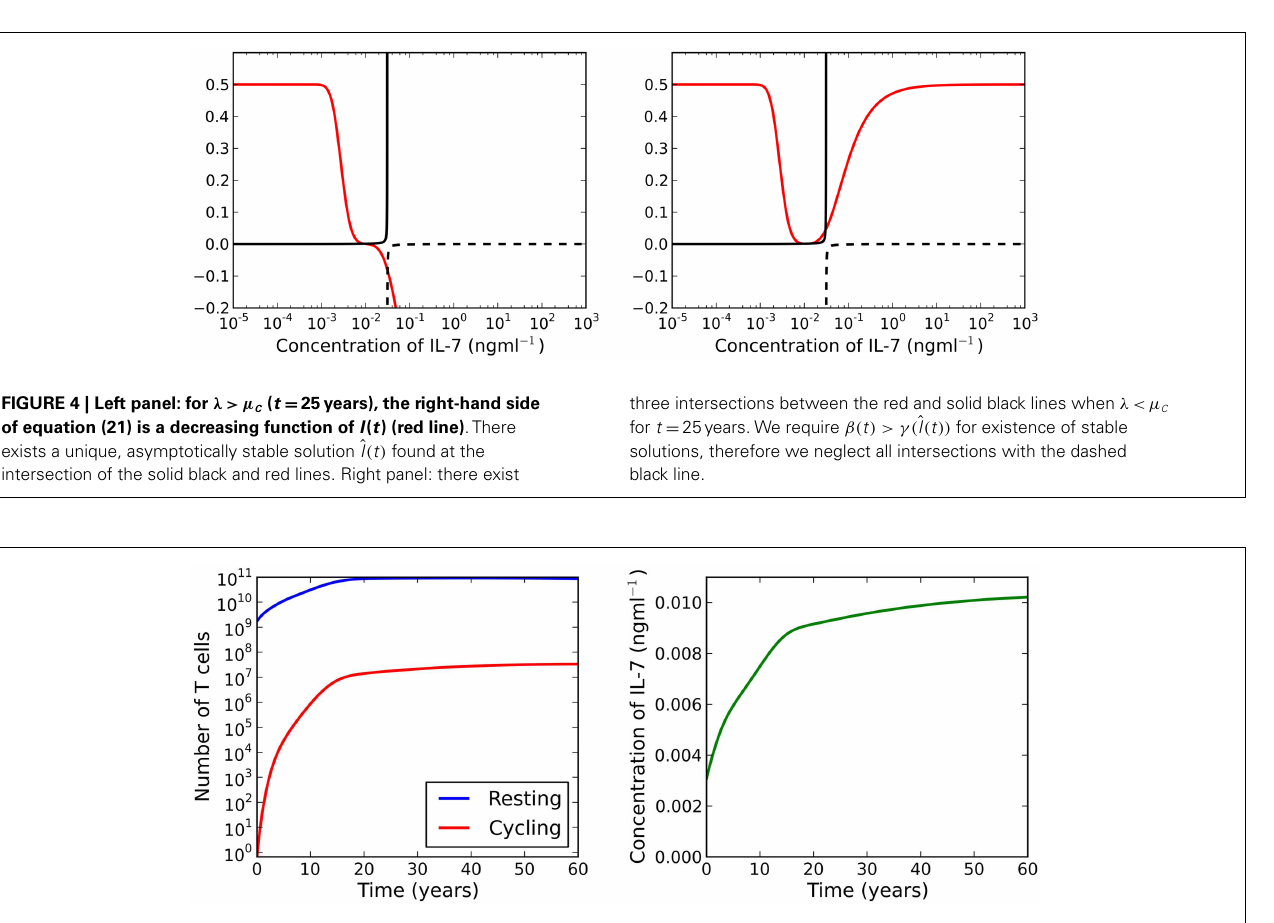
healthy individual. We have shown, under this hypothesis, that the model allows a single asymptotically stable adiabatic solution. The total number of naive T cells per kilogram of body mass was found